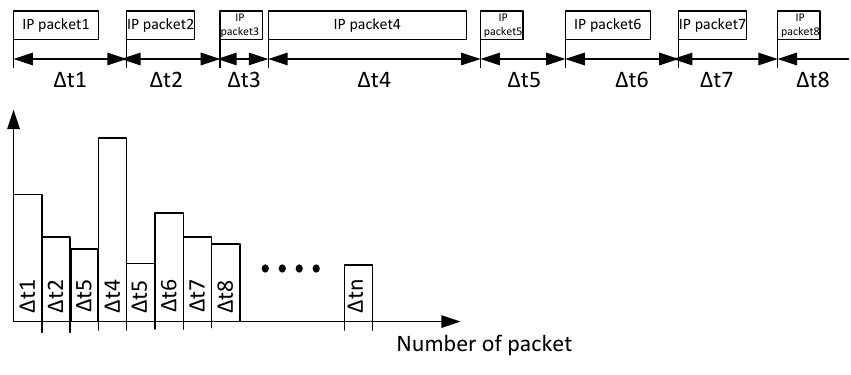
Figure 1. Tra ffi c representation. Figure 1. Traffic representation. Figure 1. Traffic representation.